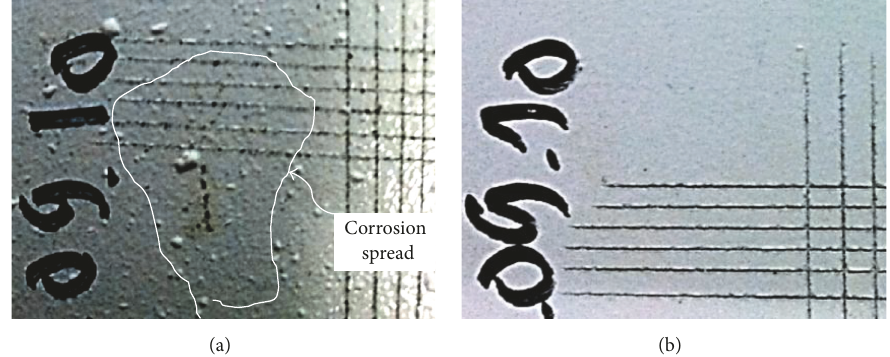
Figure 10: Corrosion resistance of a modified PCS to salt water when using (a) the CSNP and (b) the PSNP.